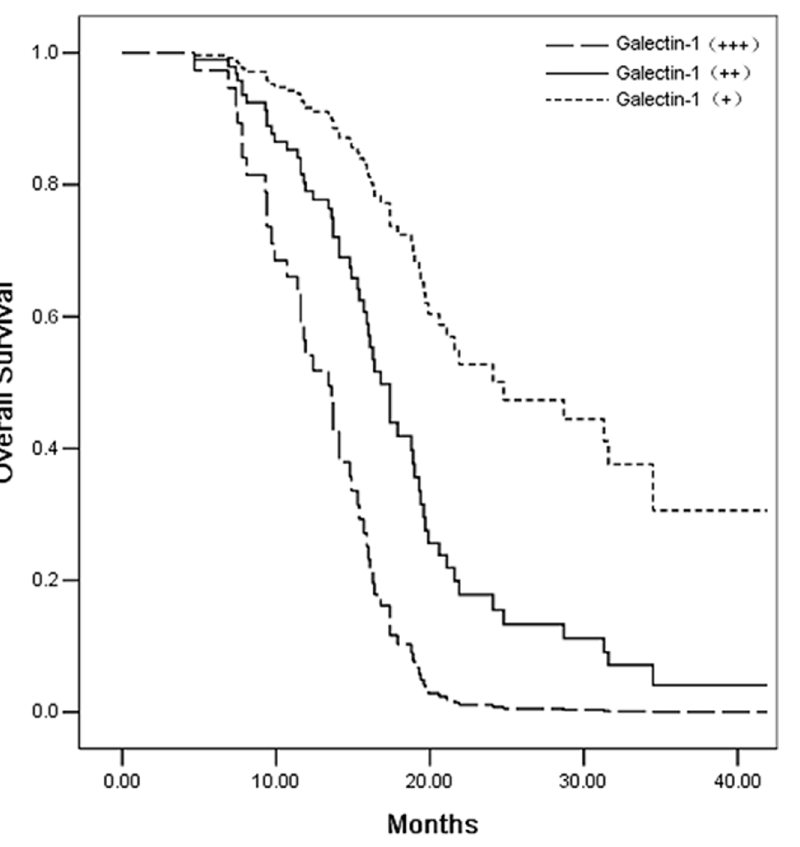
Figure 2. Kaplan-Meier survival curve for 66 pancreatic cancers with galectin-1 staining intensity in tumor associated stromal cells.